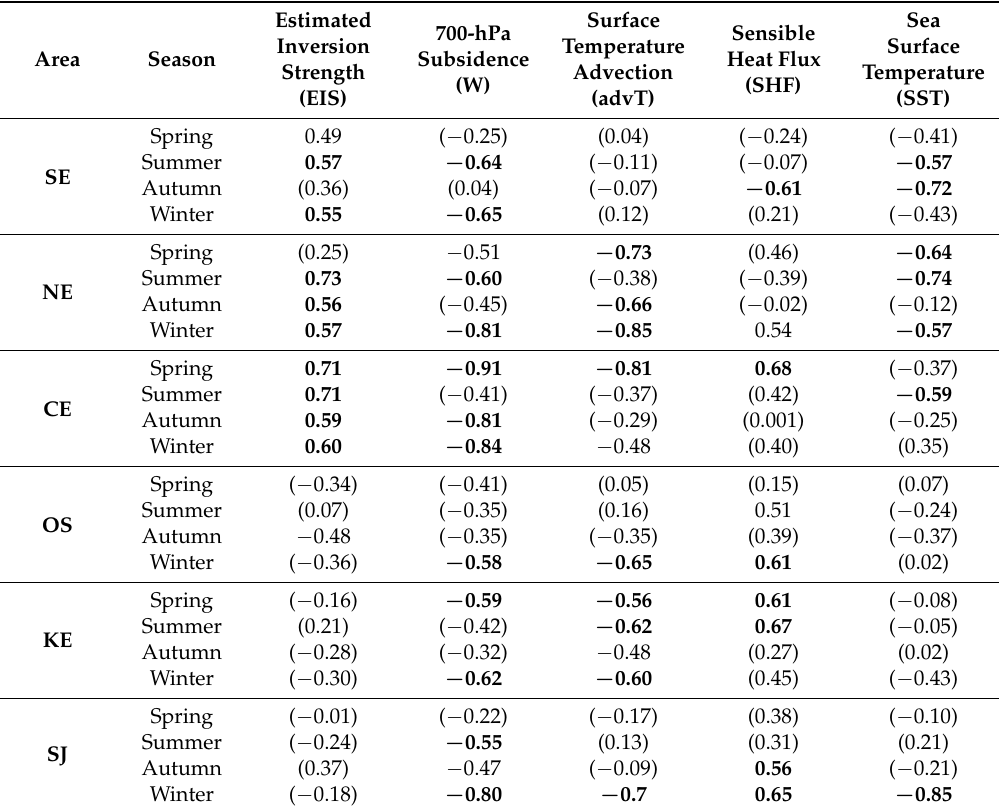
Table 2. Correlation coefficients of regionally-averaged interannual anomalies of various meteorological parameters with those of LCF. The bold type exceed a 95% confidence level, while the parentheses indicate that the correlation coefficient is not statistically significant. (SE: the southeastern North Pacific; NE: the northeastern North Pacific; CE: the center of the North Pacific; OS: the Okhotsk Sea; KE: the Kuroshio Extension; SJ: the south basin of